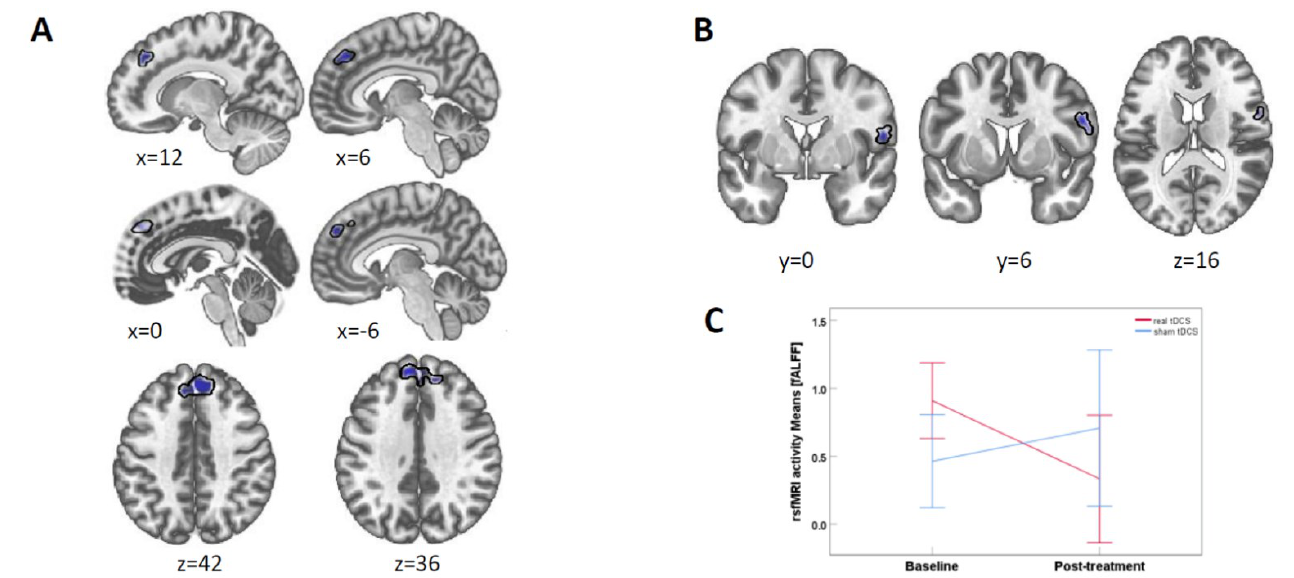
Figure 3. Resting-state fMRI results. ( A ) TPC-seeded connectivity with the superior frontal gyrus cluster (shown in blue) across all participants (i.e., real and sham group combined) was reduced for post-treatment compared to baseline. p-threshold at 0.001. ( B ) fALFF brain activity in a right precentral gyrus cluster between real and sham for baseline vs. treatment at p-threshold 0.005. ( C ) fALFF activity means for the right precentral gyrus cluster. The change in the tDCS group is significant ( p = 0.019), while it is not in the sham group. Error bars denote 95% CI.